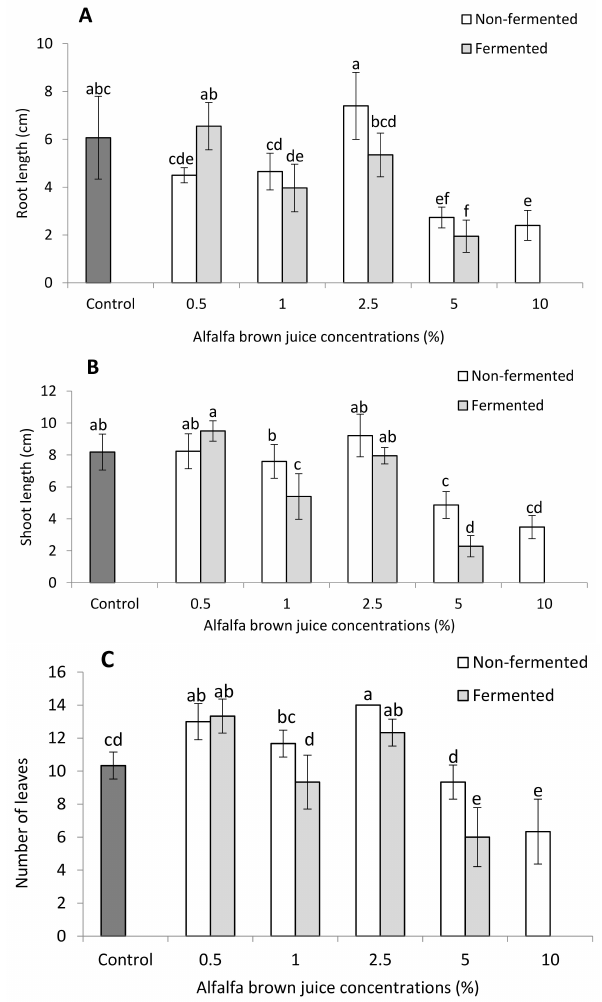
Figure 2. Effects of non-fermented and fermented alfalfa brown juice (BJ) on the ( A ) root length, ( B ) shoot length, and ( C ) number of leaves of French marigold plants ( n = 6). Different letters on top of the bars indicate significant differences ( p ≤ 0.05). Data are presented as mean ± standard deviation. Data are absent for 10% fermented BJ treatment due to the inhibitory effect of high BJ concentration; plants